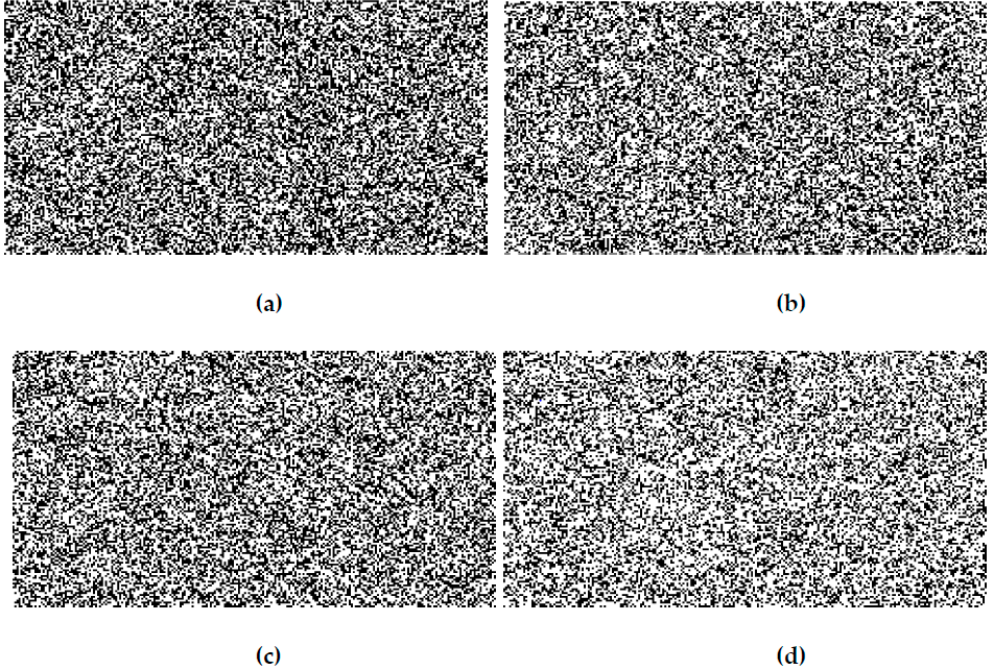
Figure 11. Black & White Data Images ( a ) Image 1, ( b ) Image 2, ( c ) Image 3, ( d ) Image 4.